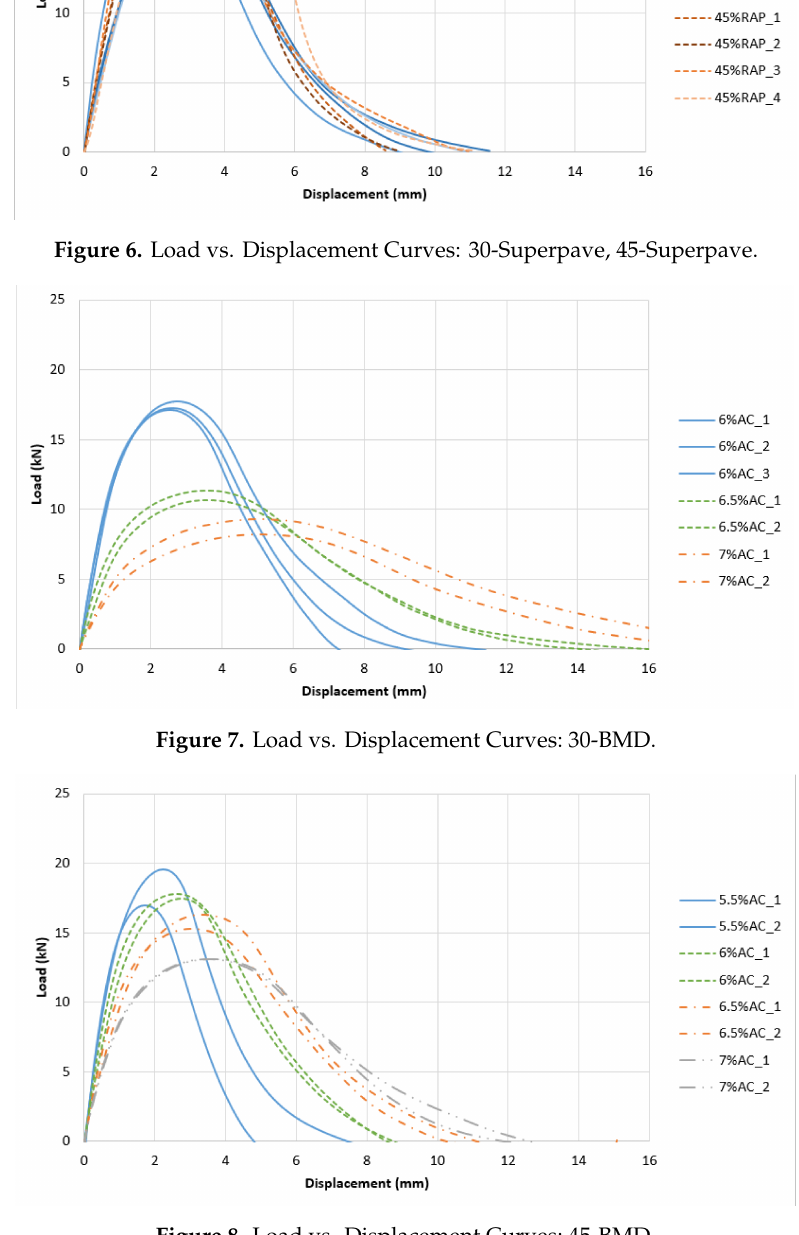
Figure 8. Load vs. Displacement Curves: